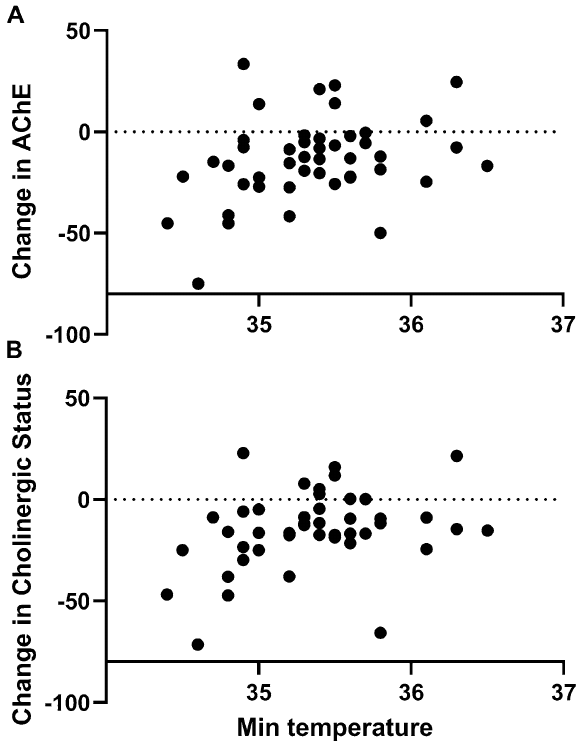
Figure 2. Correlation between minimal body temperature and the delta of AChE and total cholinergic status from the baseline to the end of